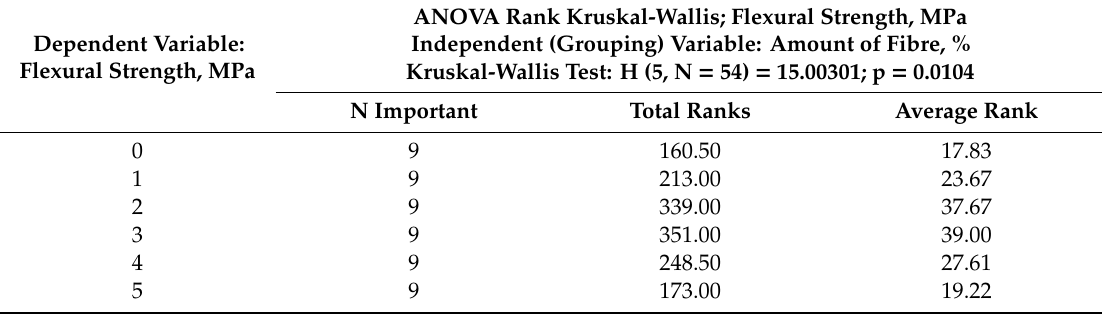
Figure 6. Categorized histograms of flexural strength related to the type of fibres. Table 7. Results of the Kruskal-Wallis ANOVA rank test for flexural strength related to fibre content.